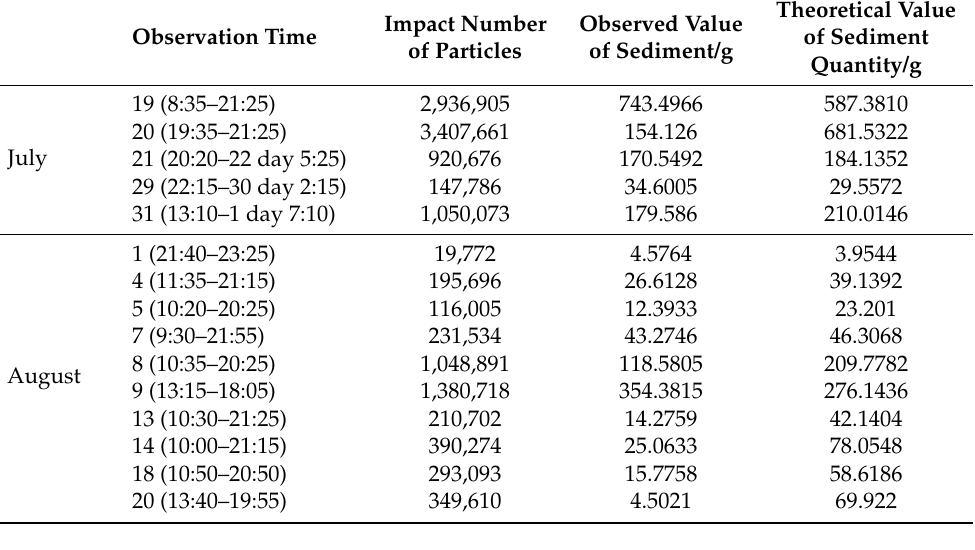
Table 2. Observed saltation particle numbers and observed and theoretical sand masses.